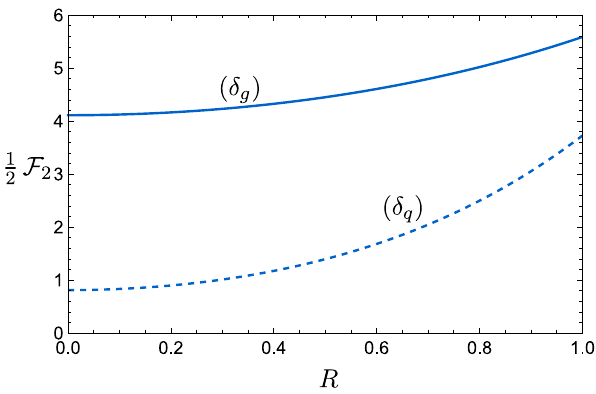
Figure 3 . Coefficient of CLs at two loops for the two channels ( δ q ) and ( δ g )